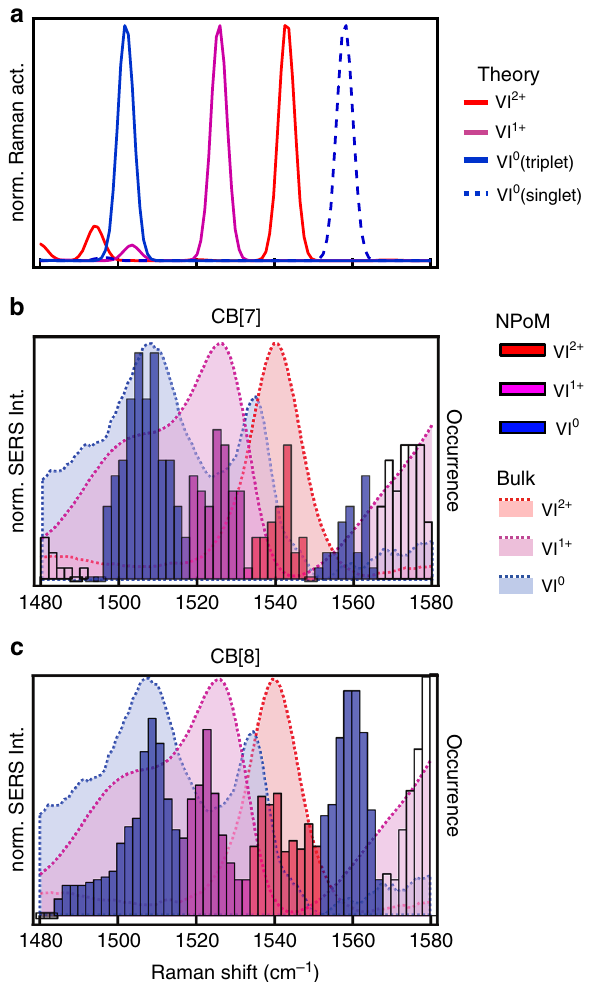
Fig. 5 Occurrence of different VI redox states in CB[ n ]. a DFT calculated peak positions for four different redox states of VI : 2 + , 1 + , 0 (singlet), 0 (triplet). b , c Histograms of single-molecule vibrational peak occurrence from NPoM constructs using b CB[7]- VI , and c CB[8]- VI complexes, compared to bulk reduction experiments (shaded